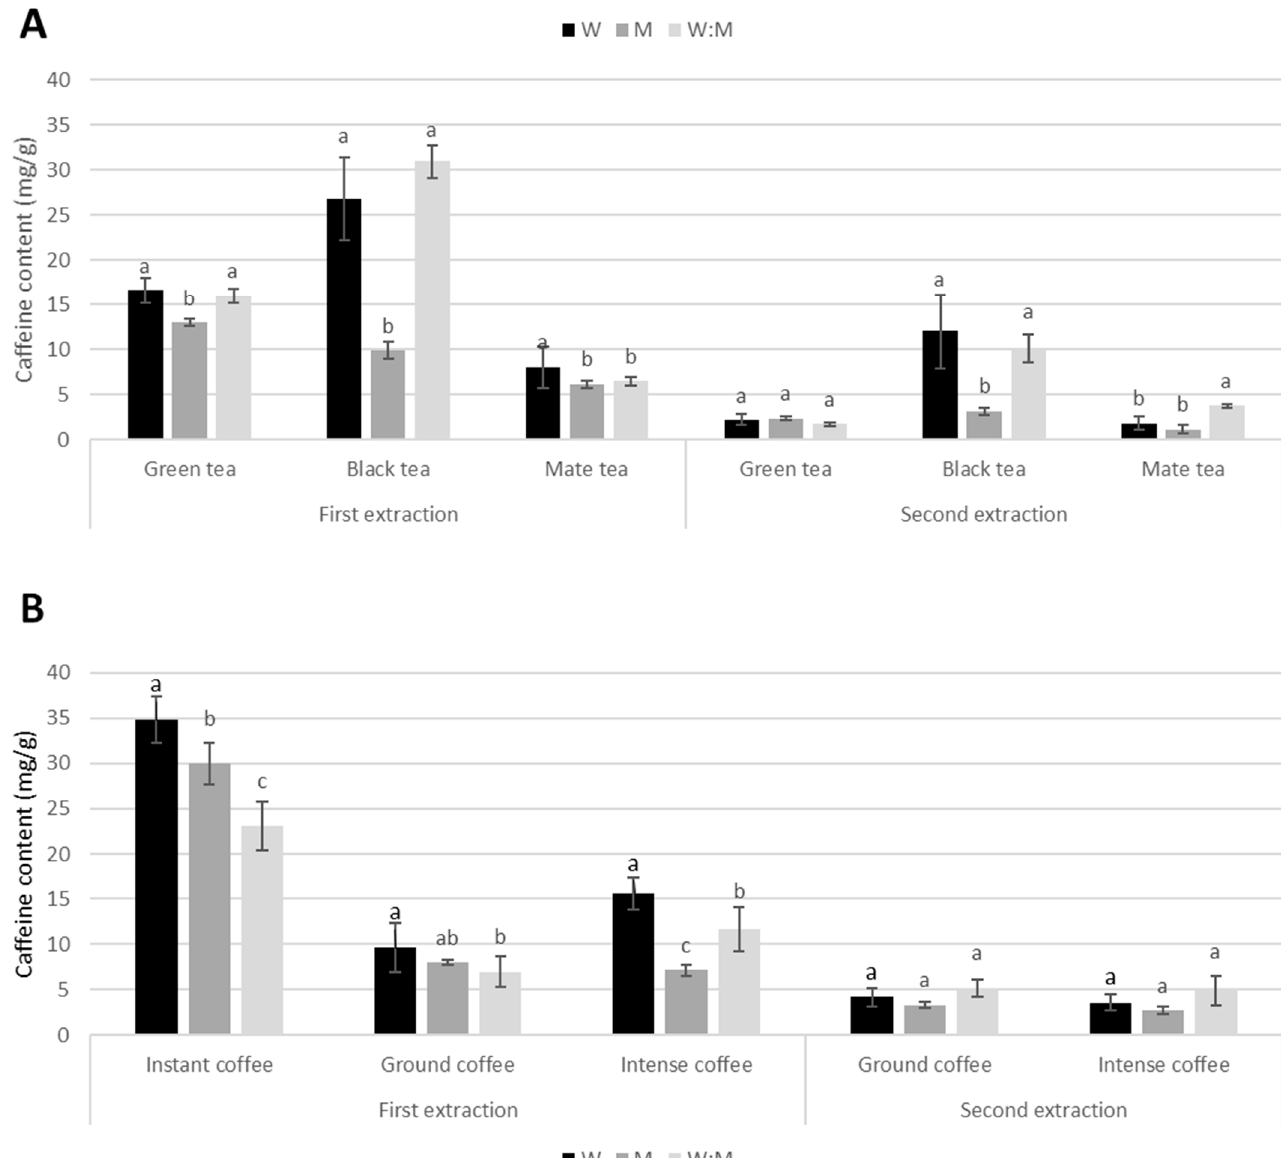
Figure 1. Caffeine content (mg/g) during first and second extraction with different solvents (W: water, M: 100% methanol; W:M: water:methanol mix) in commercial brands of ( A ) teas and ( B ) coffees. Different letters indicate statistical significance ( p ≤ 0.05) in caffeine content between solvents.